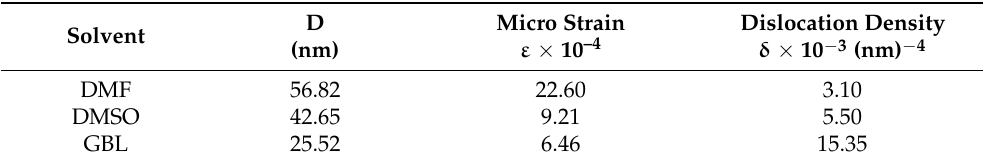
Table 2. Parameters of the (110), (220), (310), and (224) diffraction peaks extracted from the XRD patterns and the related profile-fitting results from the W-H